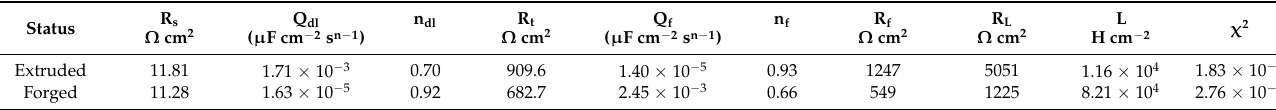
Figure 11. Equivalent circuits of EIS spectra. Table 2. Fitting results of EIS